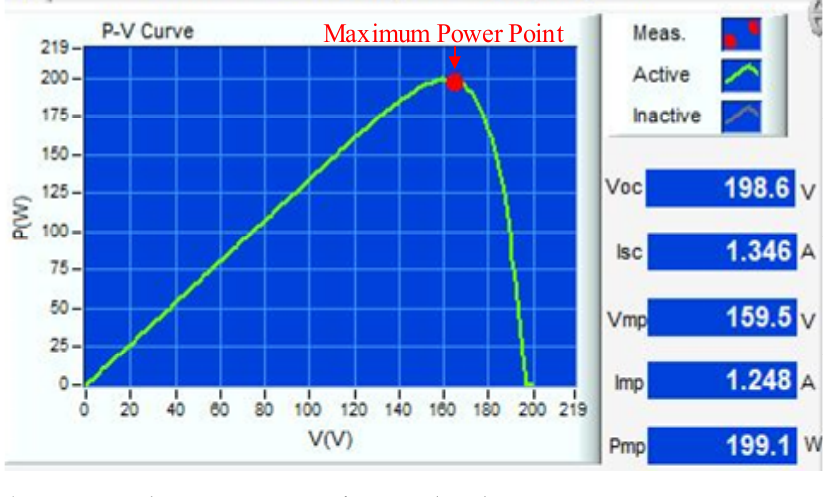
Figure 16. P-V characteristic curve of MPPT when the PVMA output power is at 200 W.